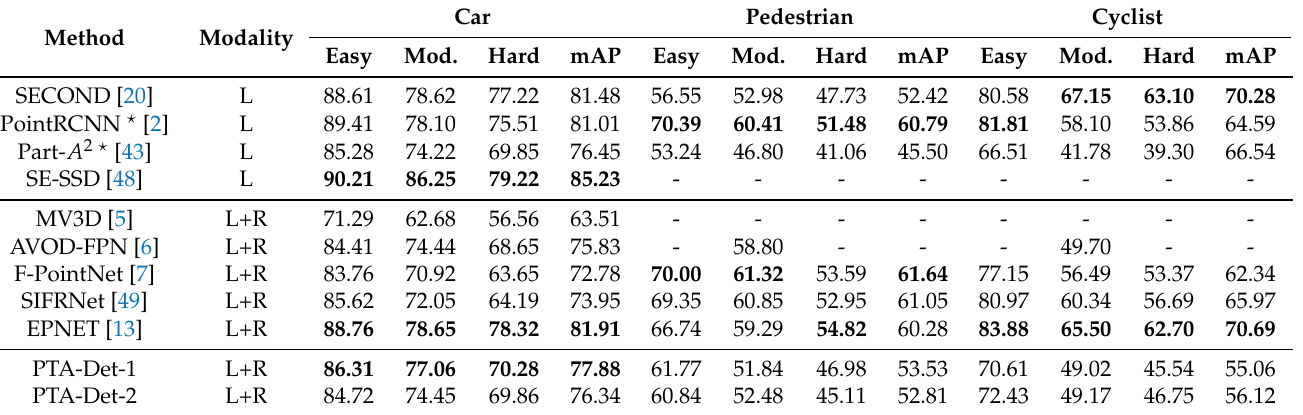
Table 1. Comparison with popular 3D object detection methods on the KITTI validation split. The available results are evaluated by mAP for each category. ‘L’ and ‘R’ stand for LiDAR and image, respectively. (cid:63) indicates no data augmentation technique is applied. PTA-Det-1 and PTA- Det-2 represent our method adopts the refinement network proposed in PointRCNN and Part- A 2 , respectively. The optimal results are marked in bold font.